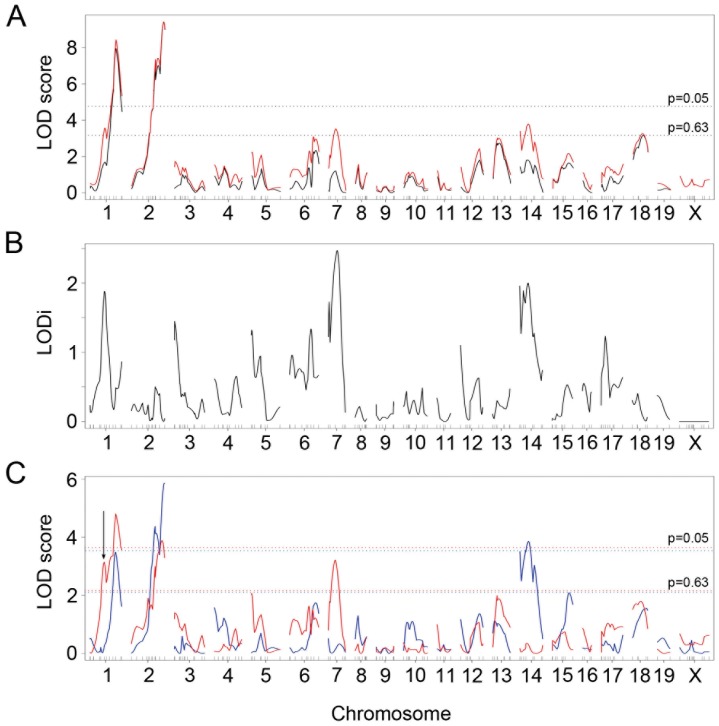
Genome-wide single QTL scans for atherosclerotic plaque size at the root.(A) LOD curves for the root lesion with sex as an additive covariate (black line) and as an interactive covariate (red line). X-axis represents positions on chromosome (cM) and y-axis represents the LOD score. The horizontal dashed lines represent the thresholds for significant QTL (p = 0.05) and suggestive QTL (p = 0.63) in the sex-interactive model. (B) Differences in LOD curves of the sex-additive model and the sex-interactive model (LODi). (C) LOD curves for root lesion in males (blue line) and females (red line). The horizontal dashed lines represent the thresholds for significant QTL (p = 0.05) and suggestive QTL (p = 0.63) in males (blue) and females (red). The arrow indicates the second QTL on Chr 1 in females.